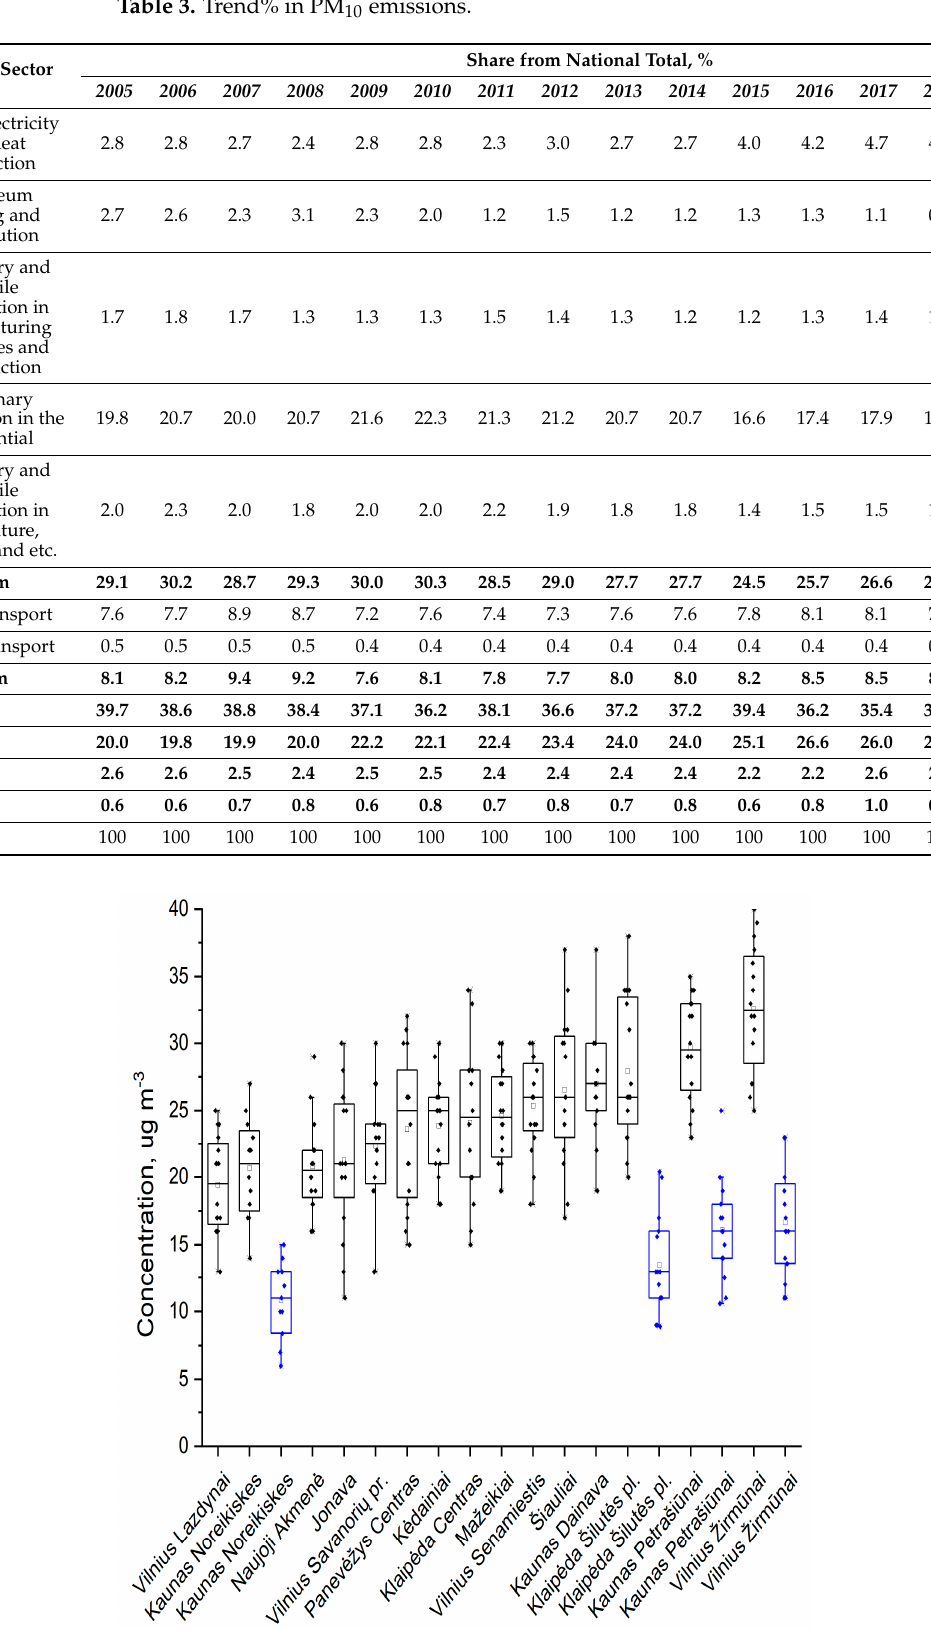
Figure 6. Box whisker plot of annual mean PM 2.5 (blue) and PM 10 (black) mass concentration in 2005– 2020 in Lithuania.